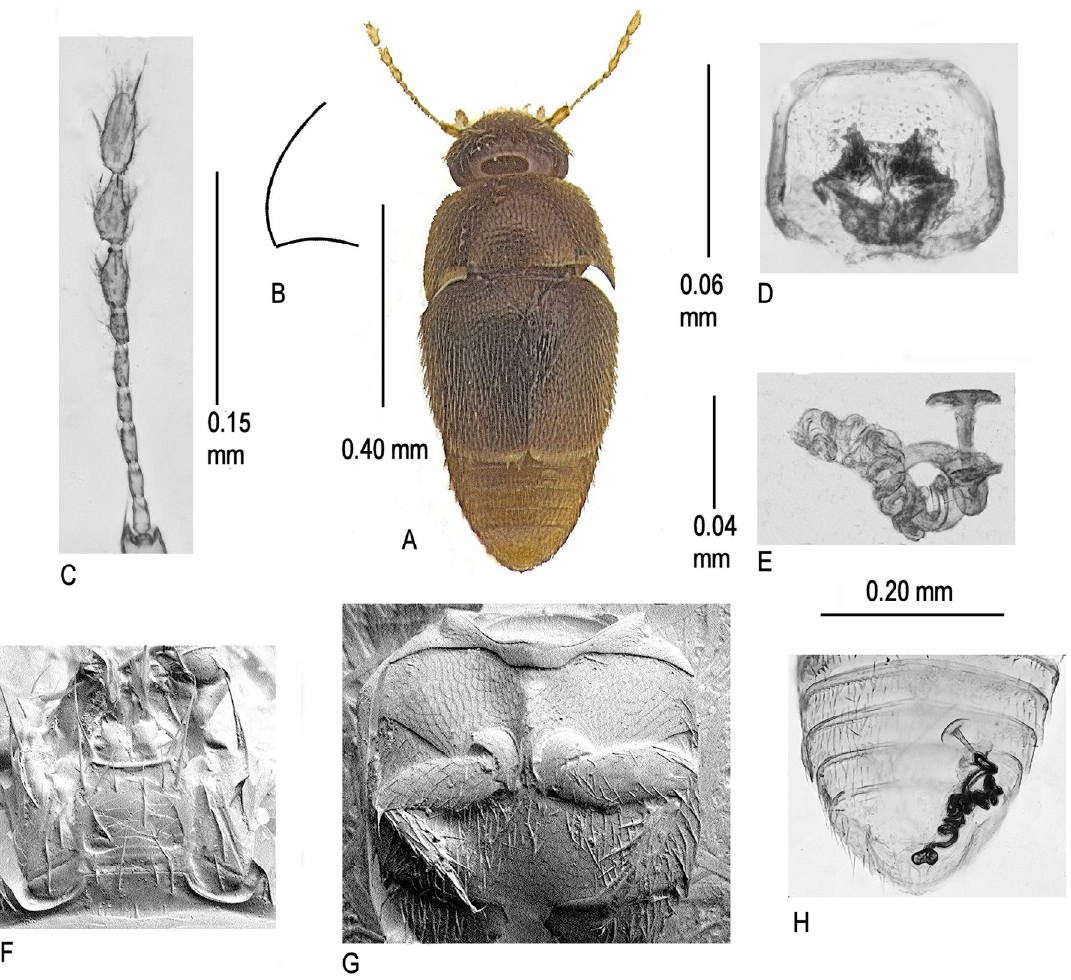
Fig. 21. Acrotrichis muluensis sp. nov. A . Habitus. B . Hind angle of pronotum viewed at 45°. C . Antennomeres III–XI. D . Aedeagus. E . Spermatheca. F . Mentum and submentum ×1120. G . Meso- and metaventra ×305. H .